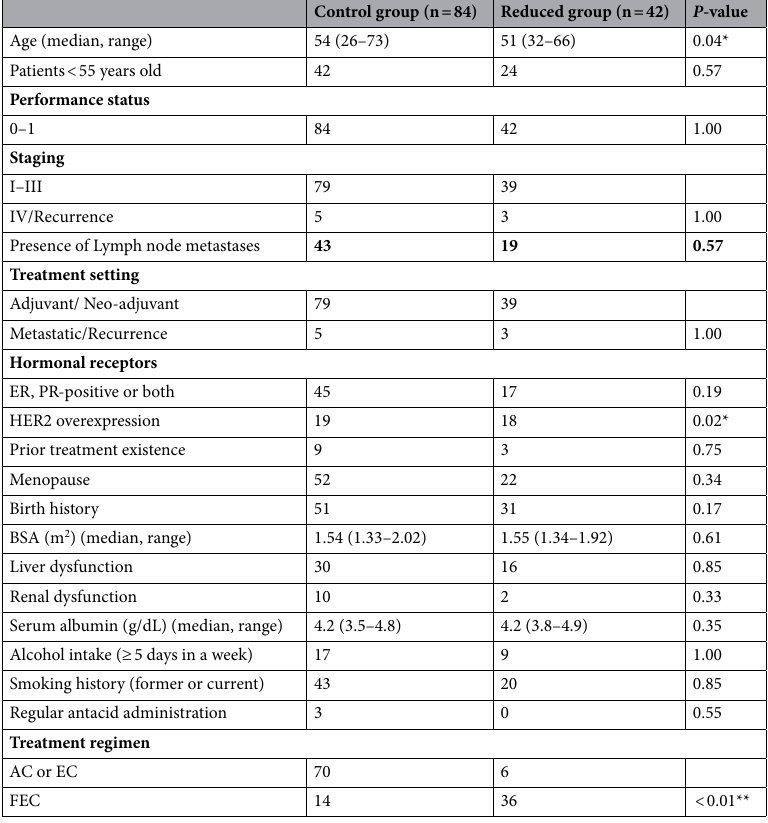
Table 1. Patient characteristics. * P < 0.05. ** P < 0.01. Significant values are in bold. ER estrogen receptor, PR progesterone receptor, HER2 human epidermal growth factor receptor 2, BSA body surface area. Liver dysfunction: grade 1 or higher aspartate aminotransferase, alanine aminotransferase, γ-glutamyltransferase, total bilirubin elevation. Renal dysfunction: grade 1 or higher serum creatinine elevation. Antacids include proton pump inhibitors and histamine type 2 receptor